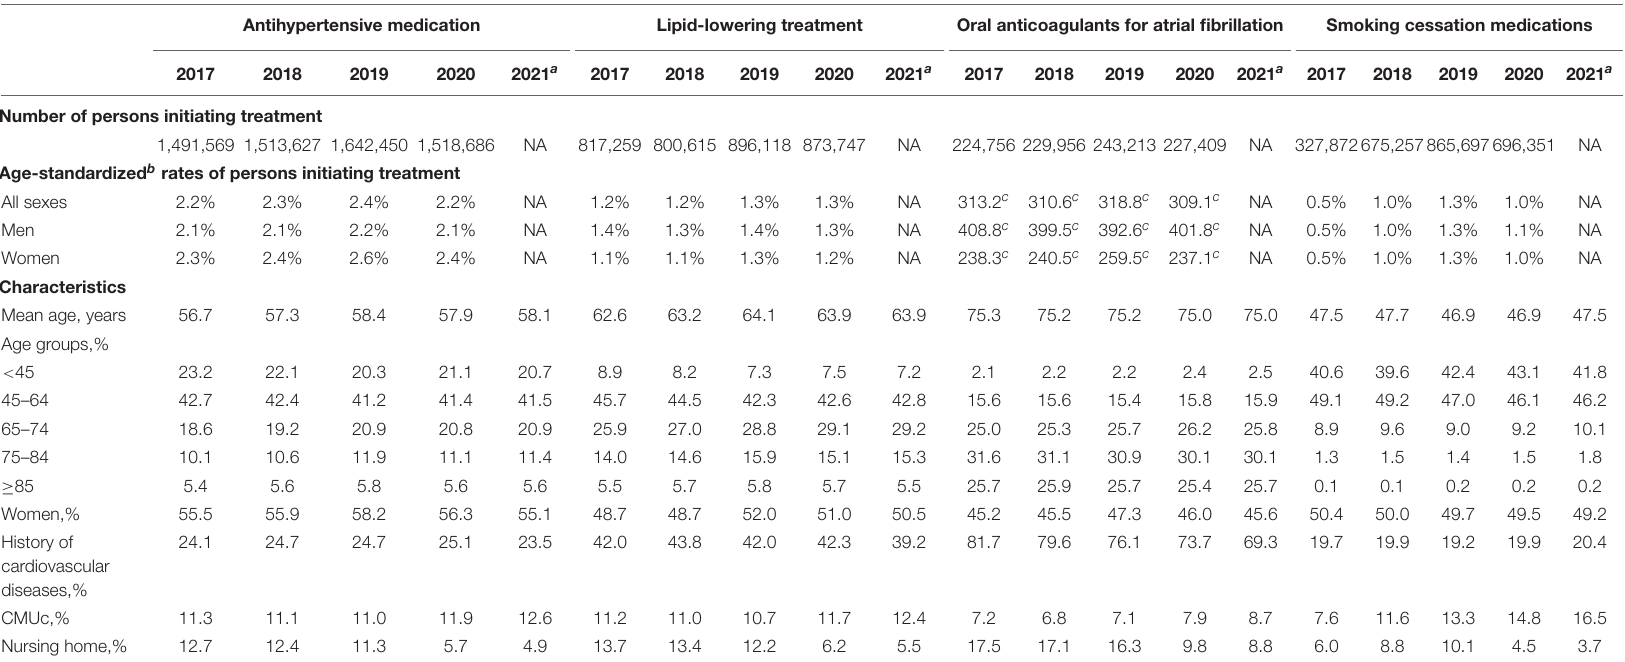
TABLE 1 | Numbers and characteristics of people who initiated a therapy of interest between 2017 and 2021, and corresponding age-standardized rates in